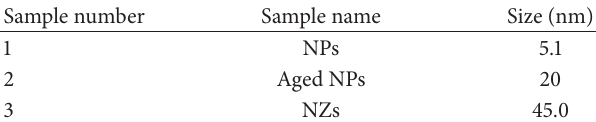
Table 1: The DLS result of nanocrystalline Beta synthesis.